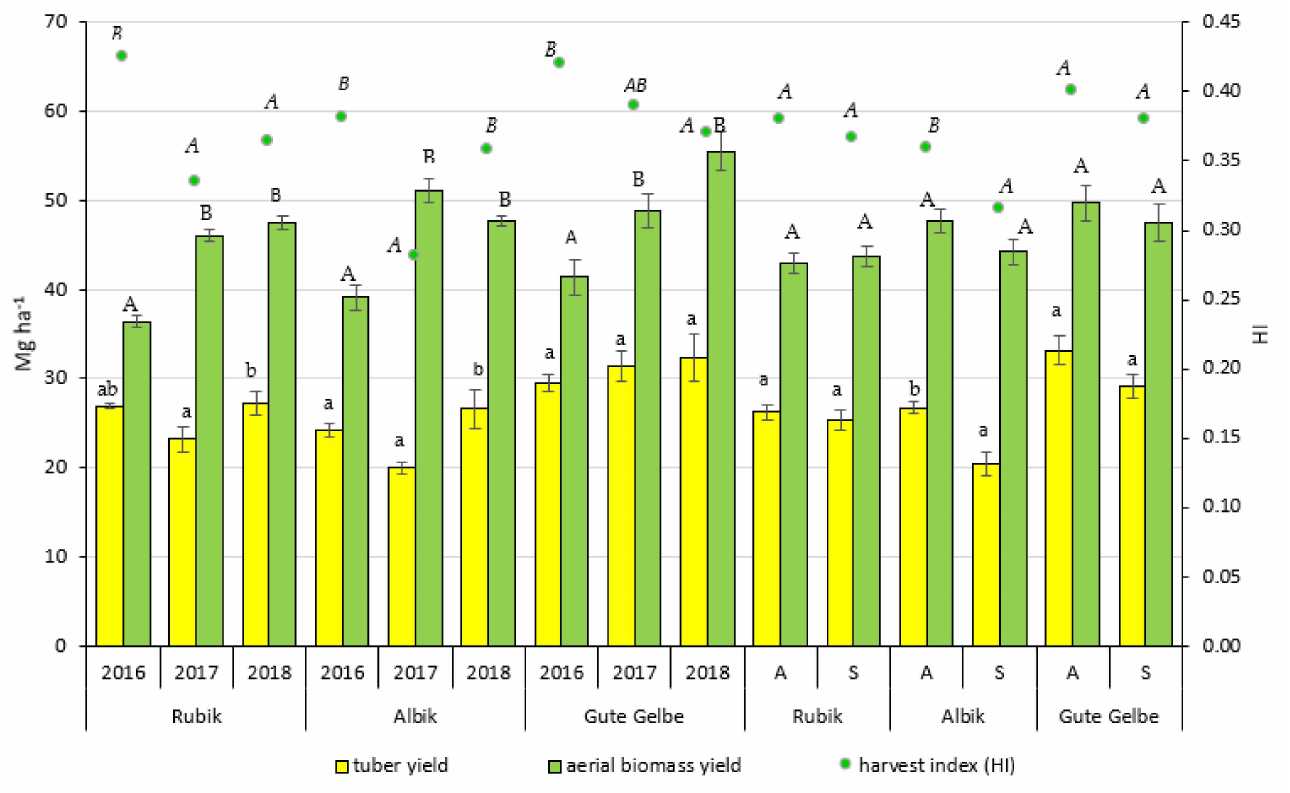
Figure 1. Jerusalem artichoke yields and harvest index (HI) (average ± SE) in the experimental years and on different harvest dates (3-year average ± SE) (Explanations: A—autumn; S—spring, SE—standard error; lower case letters for tuber yield, upper case letters for aerial biomass yield, and italicized upper-case letters for HI; bars followed by the same letters do not differ significantly at p <